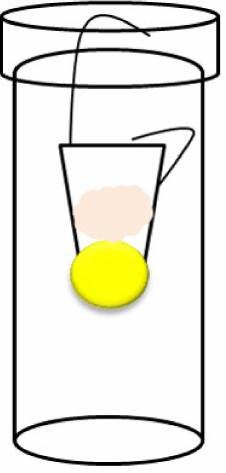
Figure 1. Insect rearing device used in the study, pink area is the moistened cotton to keep the soybean seed humidity, the yellow circle is the moistened soybean seed for R. pedestris